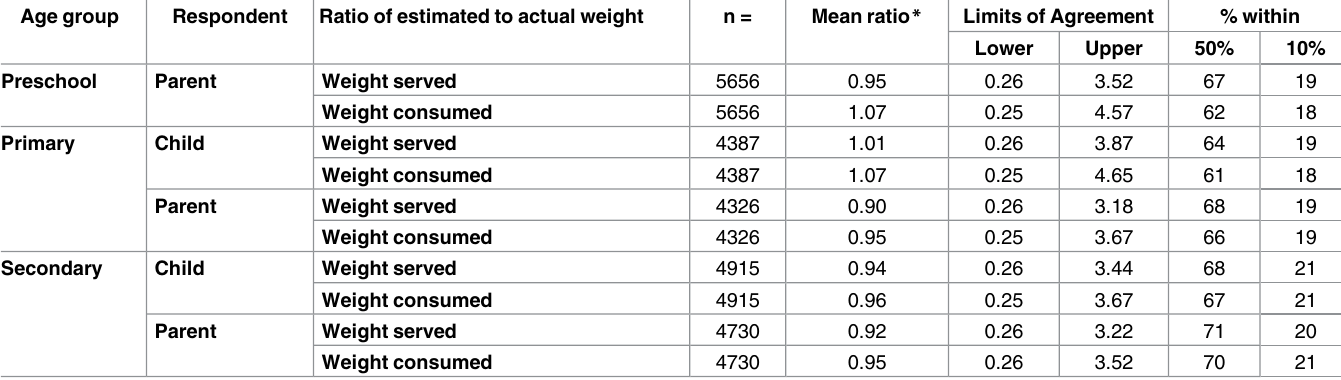
Table 2. Agreement of estimatesof portion size using YPFA with weighed food diaries—by age group and respondent.